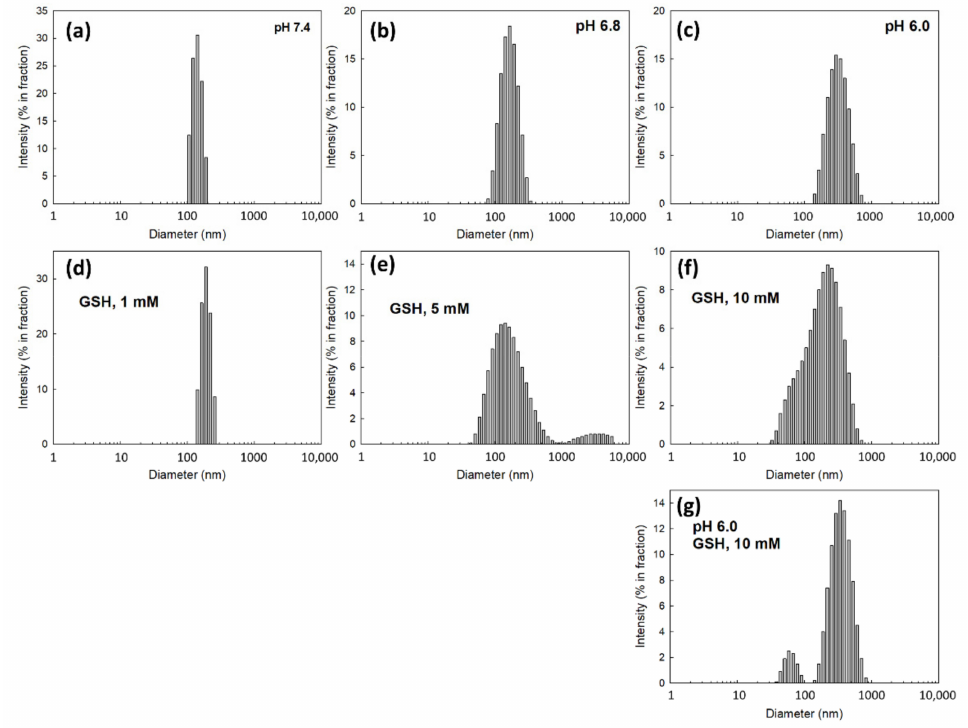
Figure 3. The effect of pH and GSH addition on the changes in particle size distribution of DOX- incorporated ChitoHISss nanoparticles. To assess the effect of pH and GSH on the particle size, 40/5 from Table 1 was used. The effect of pH: ( a ) pH 7.4; ( b ) pH 6.8; ( c ) pH 6.0. The effect of GSH addition. ( d ) GSH, 1 mM; ( e ) GSH, 5 mM; ( f ) GSH, 10 mM. ( g ) pH 6.0 and GSH addition. Nanoparticle solution was incubated at each pH and/or with the addition of GSH for 2 h at 37 ◦ C. Particle size was measured by Zetasizer Nano-ZS ® (Malvern, Worcestershire,